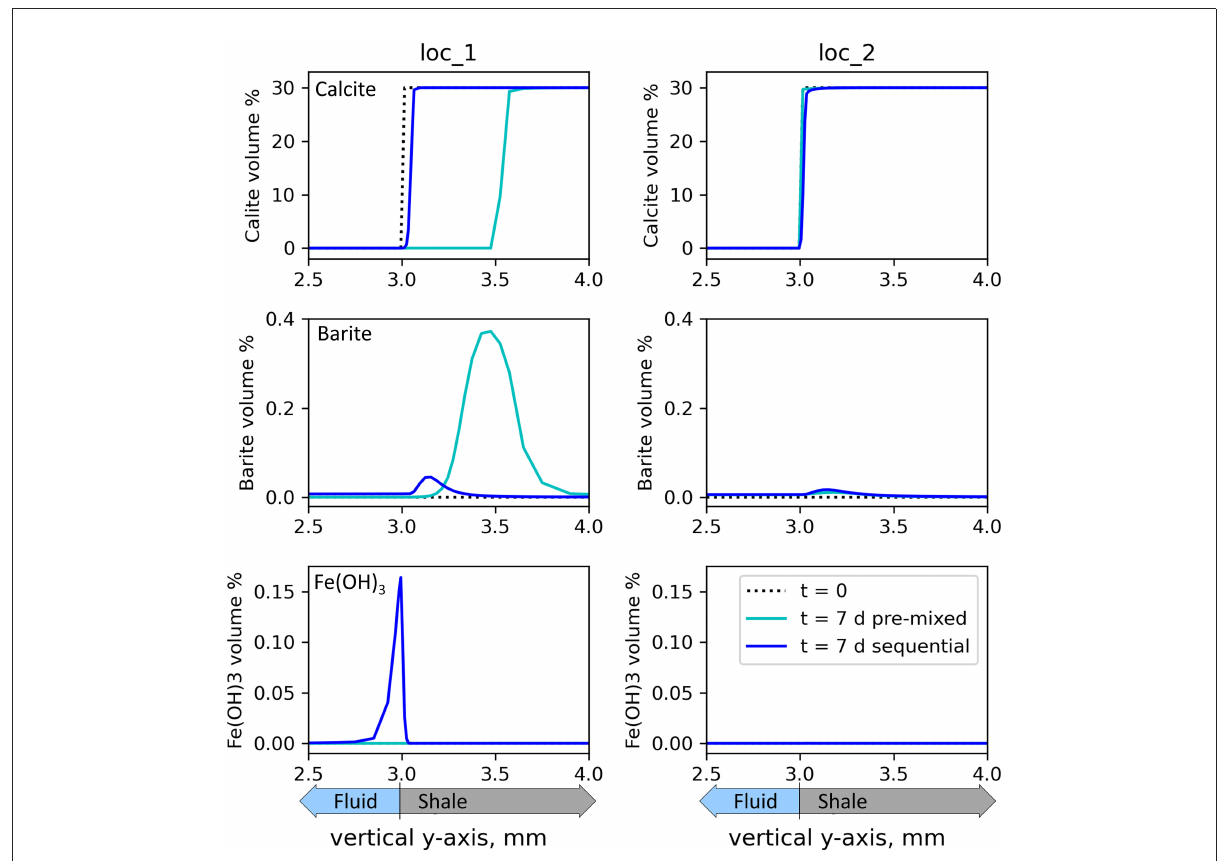
FIGURE7 Mineral volume percentages along vertical 1D transects at location #1 (loc_1, 0.2m from injection point) and location #2 (loc_2, 200m from injection point) in the 2D pre-mixed and sequential flow-through models. The transect locations are illustrated in Figure 2. The fluid-shale interface is positioned at 3.00mm on the horizontal axis (which denotes the y axis in the 2D model), with fracture fluid on the left and shale matrix on the right. In the pre-mixed model, both calcite dissolution and barite precipitation occur more noticeably at loc_1 than loc_2. Fe(OH) 3 precipitation is negligible. In the sequential model, calcite dissolution occurs at both locations with narrow reaction zones. Barite precipitation also occurs at both locations, inside the shale matrix. Fe(OH) 3 precipitates in the fracture space and only at